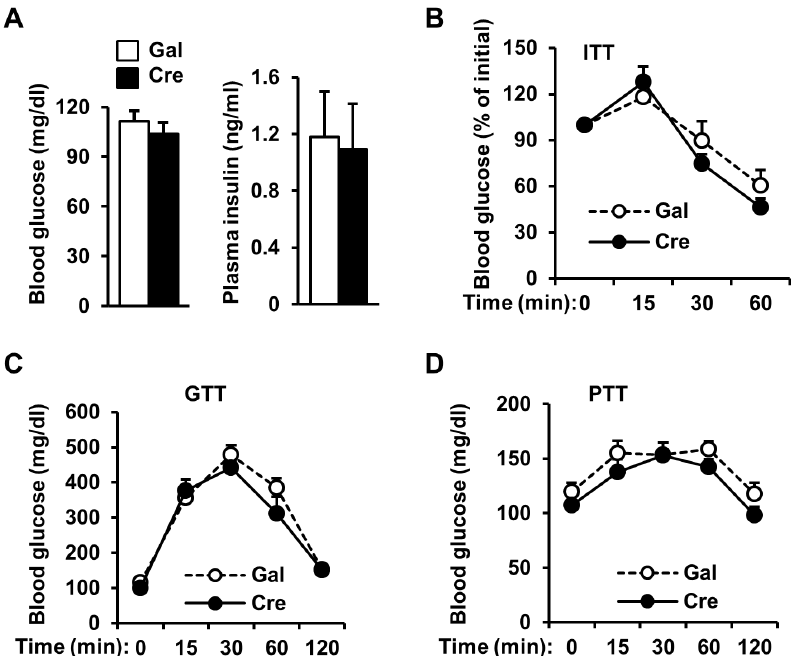
Figure 5. Deletion of both SH2B1 and SH2B2 in the liver does not exacerbate HFD-induced insulin resistance and glucose intolerance. SH2B1 f/f :SH2B2 KO male mice (7 weeks of age) were fed a HFD for 5 weeks and infected with b -gal (n=6) or Cre adenoviruses (n=6) via tail vein injection. (A) Overnight fasting blood glucose and plasma insulin levels 10 days after adenoviral infection. (B) ITT (13 days after adenoviral infection). (C) GTT (16 days after adenoviral infection). D-glucose: 1 g/kg body weight. (D) PTT (19 days after adenoviral infection). Data are presented as means 6 SEM. P , 0.05.